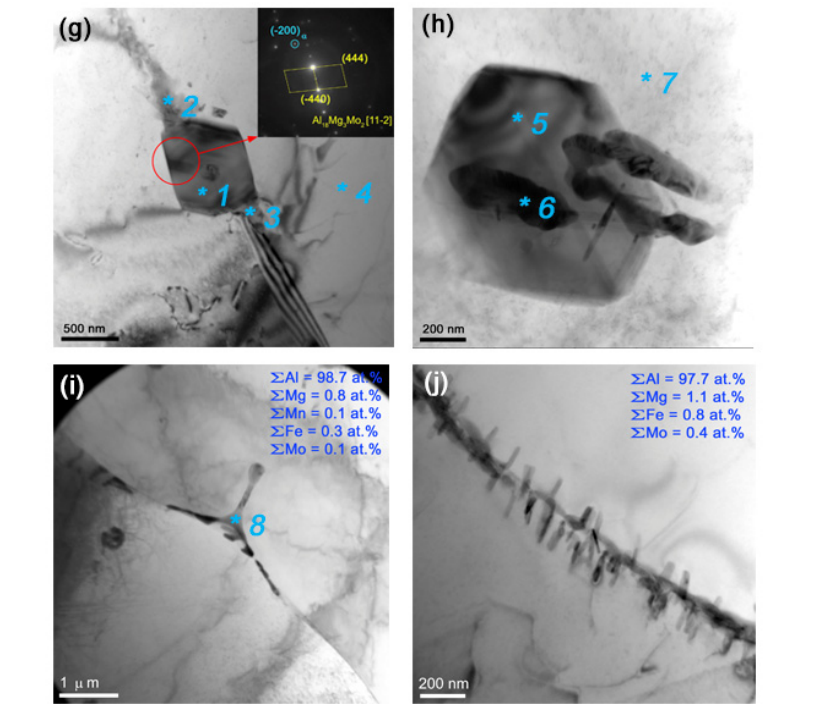
Figure 7. SEM BSE image and EDS maps of zone 2 AA5154/Mo microstructures obtained with 0.3 g/layer Mo ( a – f ). TEM images ( g – j ) and SAED pattern showing the IMCs formed. Numbers 1–7 denote points selected for EDS (Table 3). Table 3. EDS analysis of the AA5154/Mo with 0.3 g/layer was obtained by using TEM (Figure 7g–j). Concentration of Elements, at.% Spectrum